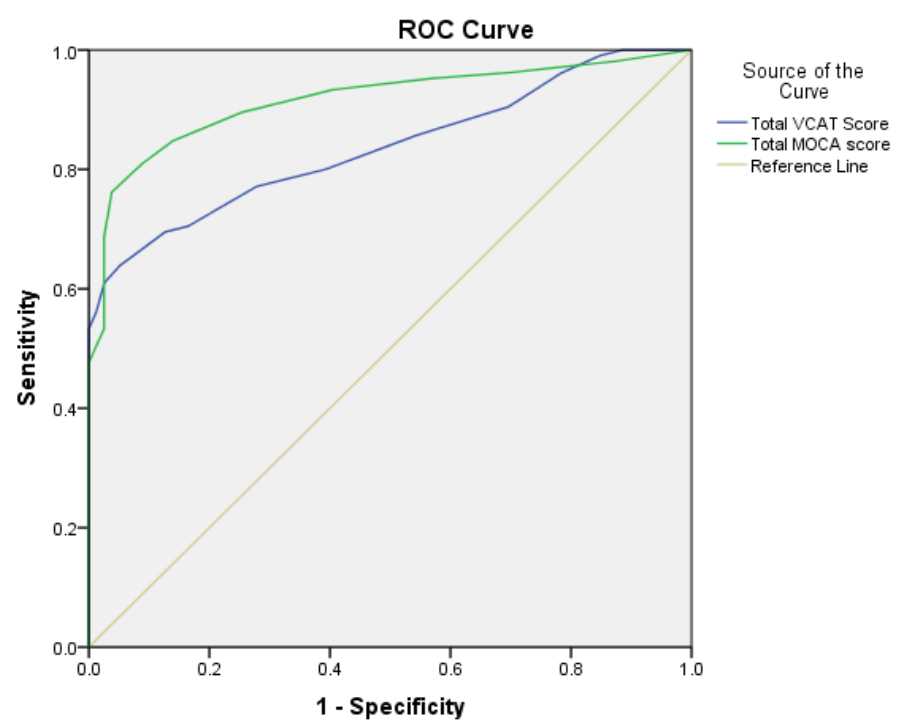
Figure 1. Receiver operating characteristic (ROC) curves: area under the curve (AUC) for discrimi- nating between CHP (Cognitively Healthy Participants) and CI (Cognitive Impairment) participants on VCAT and MoCA scores. MoCA Montreal Cognitive Assessment, VCAT Visual Cognitive Assess- ment Test.